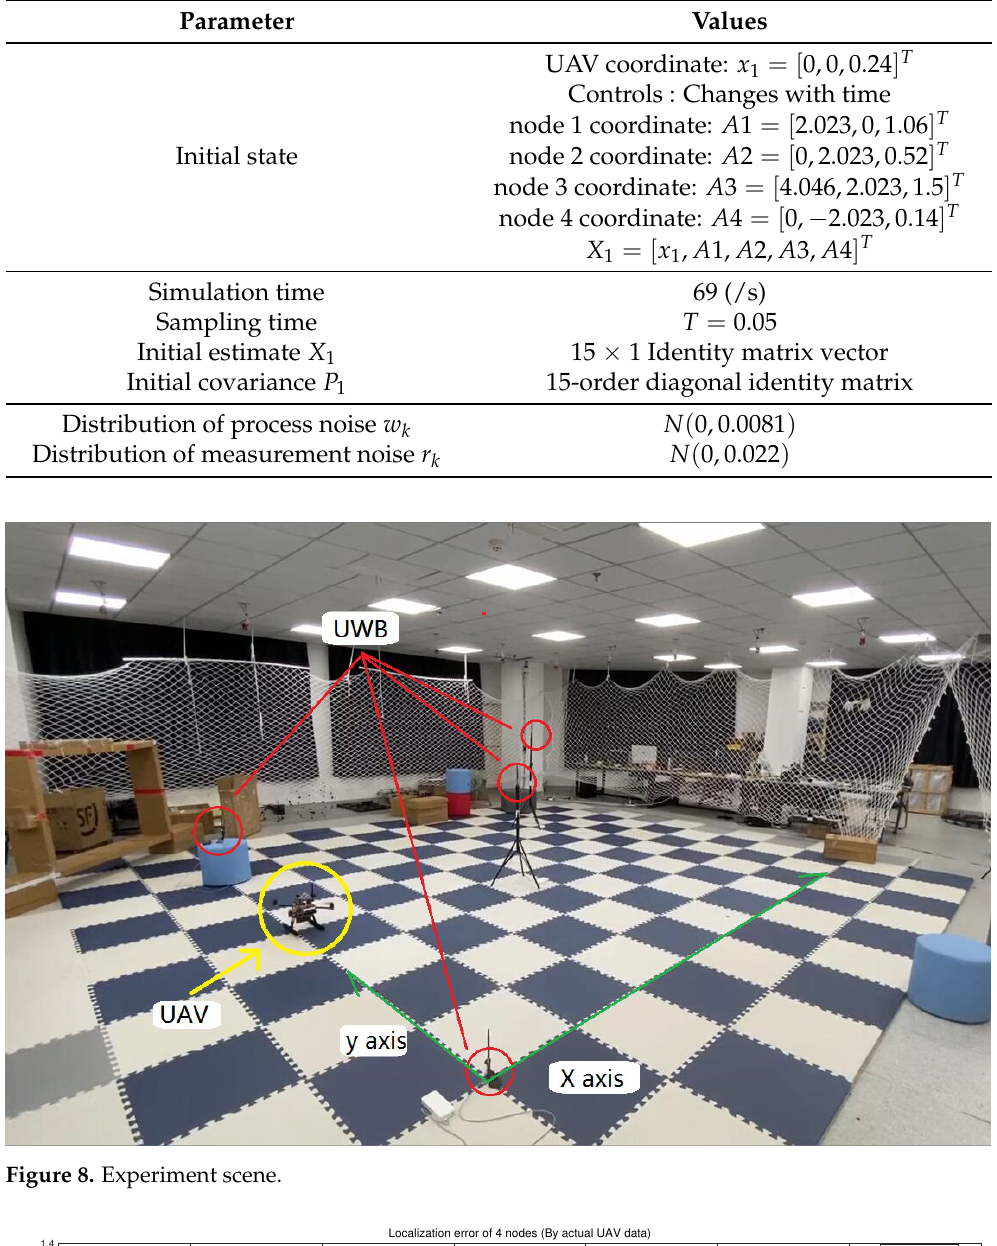
Table 6. Parameters used in the experiment.